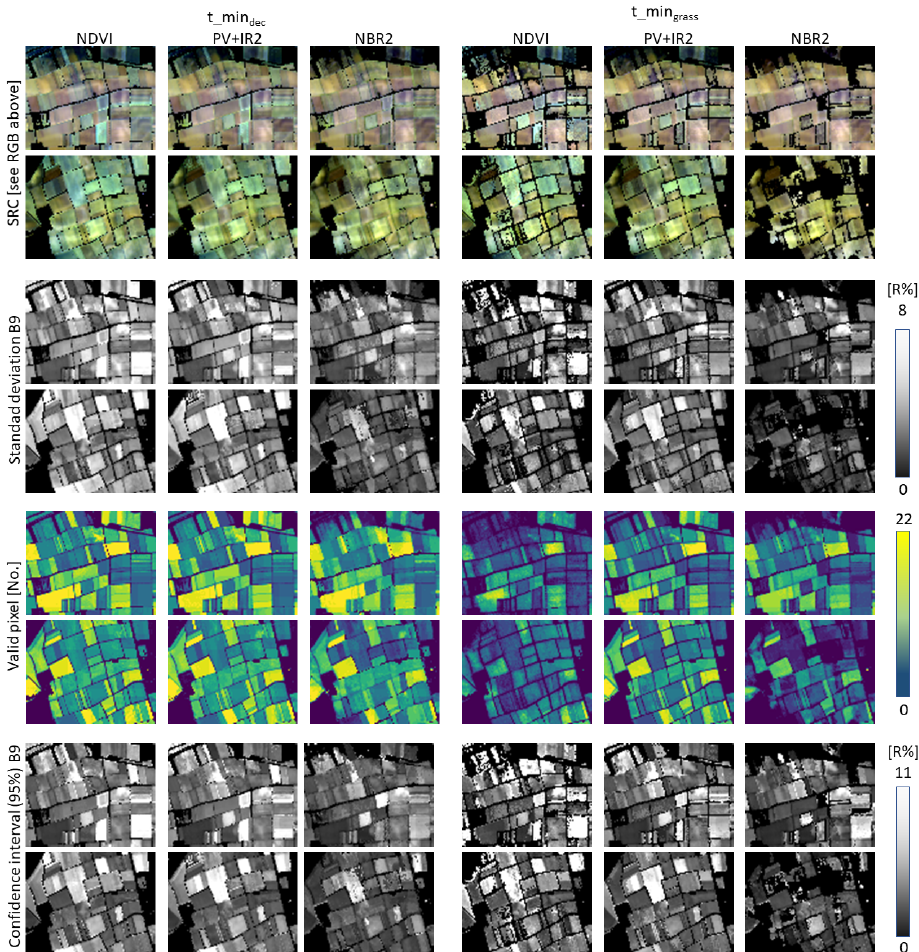
Figure 7. SRC subset around Noerdlingen, Germany. Subsets A and B for all processed versions (see Table 3) show details about the spatial and spectral variability of the SRCs. The RGB of examples A and B are the same as used for the large subset; R =